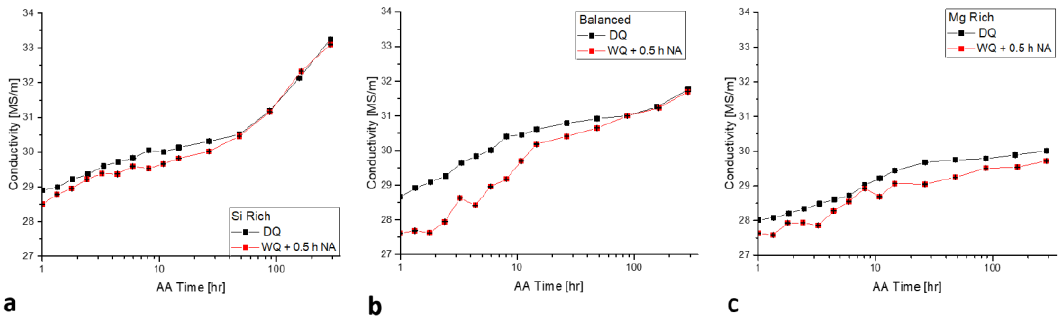
Figure 9. AA conductivity evolutions of the high strength alloys in the DQ condition, compared to traditional WQ followed by short (0.5 h) NA, labelled accordingly. Error bars are not visible at 95% confidence.